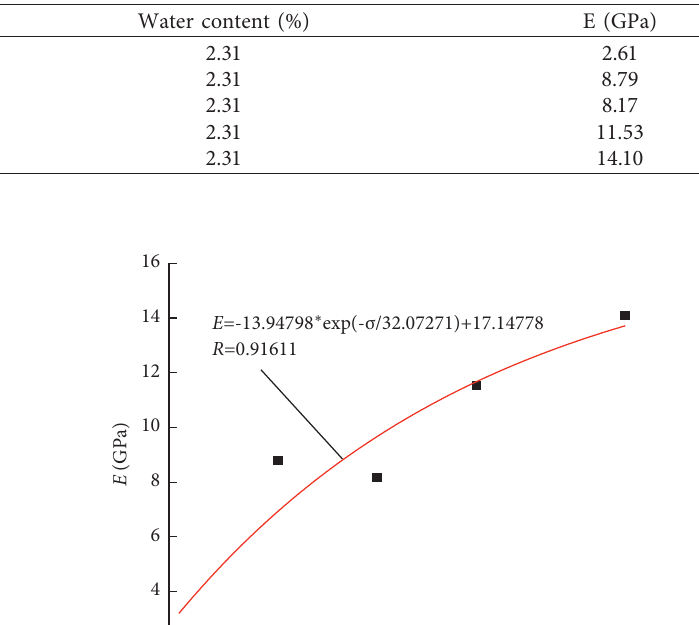
Table 2: Mechanical parameters of sandstone under different confining pressures.